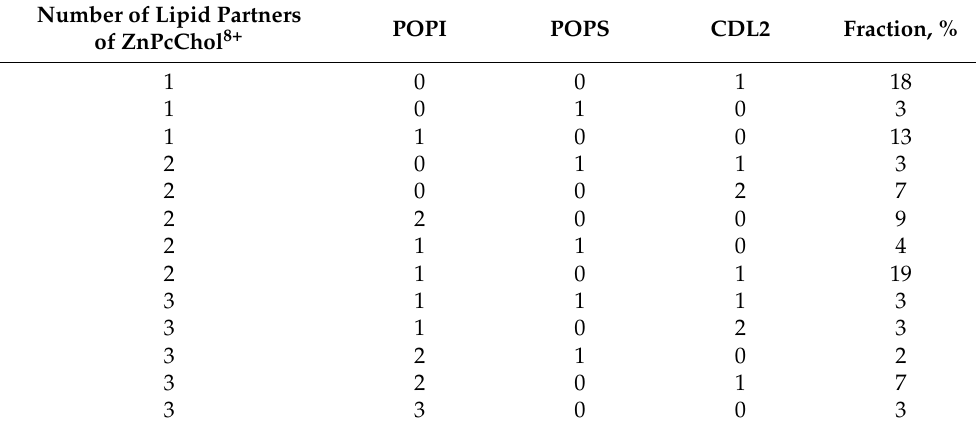
Table 2. Distribution of electrostatic complexes of ZnPcChol 8+ with negatively charged lipids by the number of contacts with different lipid types. The cases with occurrence less than 2% are omitted. Number of Lipid